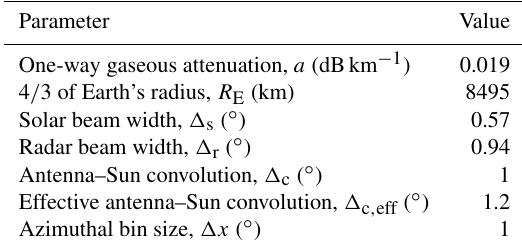
Table 1. Summary of parameters used in the Sun calibration. The radar beam width refers to the C-band radars managed by Arpa